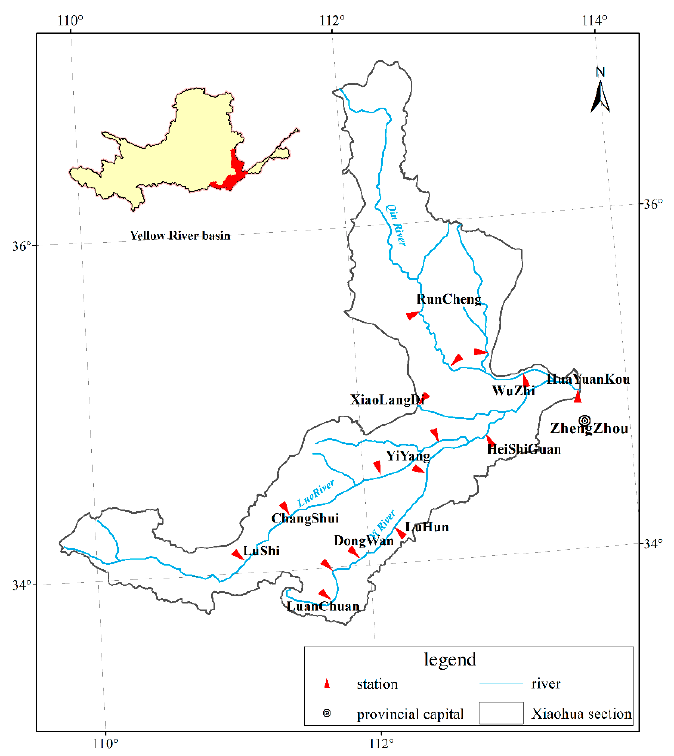
Figure 1. The location of the Xiaohua section of the Yellow River.